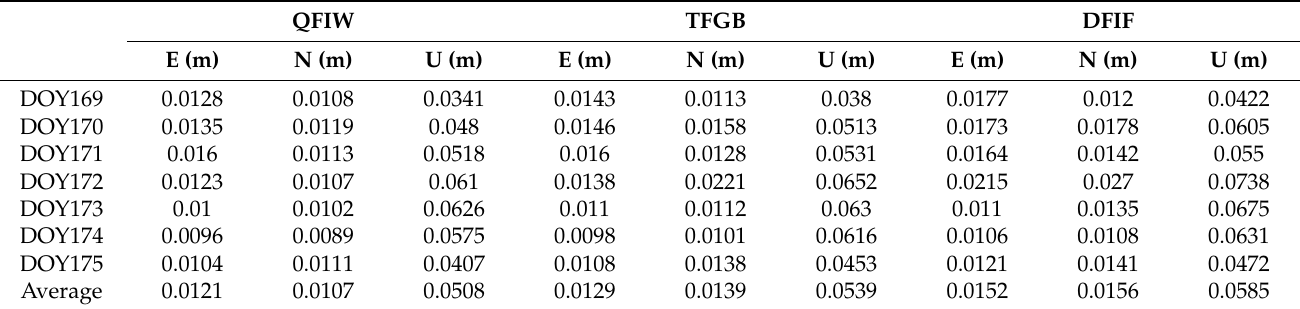
Table 5. Positioning error statistics of three